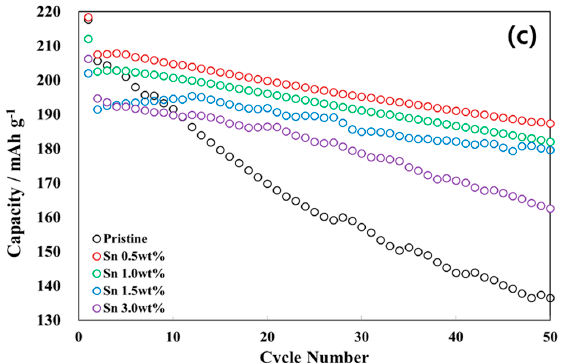
Figure 8. Cycling performance of the cathode active materials at room temperature from 3.0 to ( a ) 4.3, ( b ) 4.4, or ( c ) 4.5 V (0.1 C for the 1st cycle and 0.5 C from the 2nd cycle).